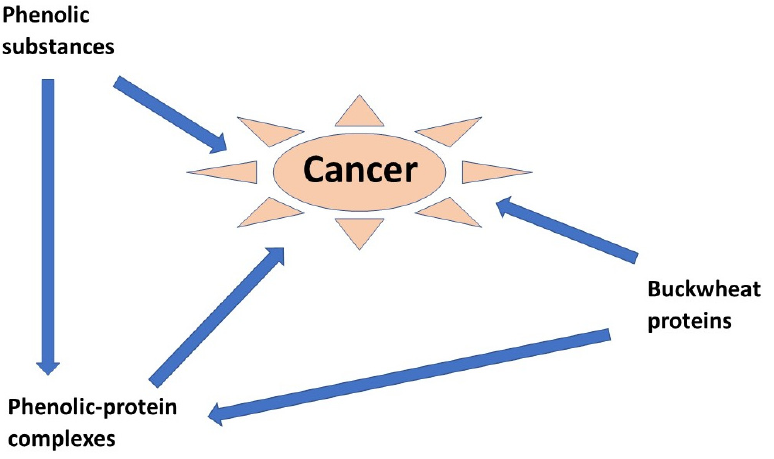
Figure 6. Pathways of alleged suppression of appearance of cancer, according to the references